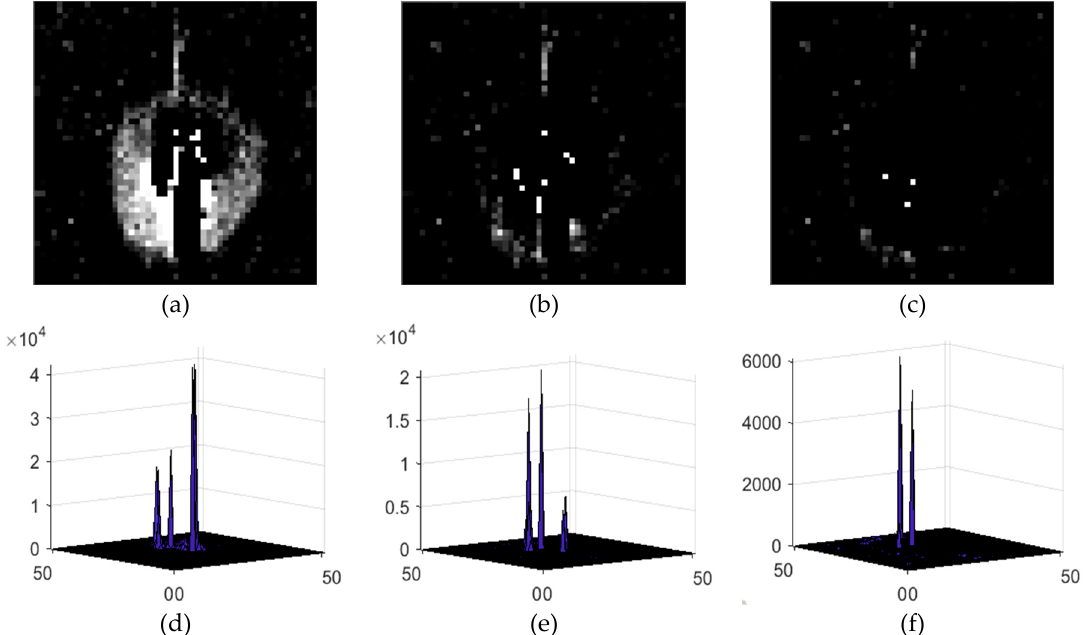
Figure 8. Result image and corresponding gray distribution of di ff erent di ff erential algorithms: ( a ) absolute di ff erence result image; ( b ) dilation di ff erence result image; ( c ) enhanced dilation di ff erence result image ( η = 2); ( d ) absolute di ff erence gray distribution; ( e ) dilation di ff erence gray distribution; ( f ) enhanced dilation difference gray distribution.